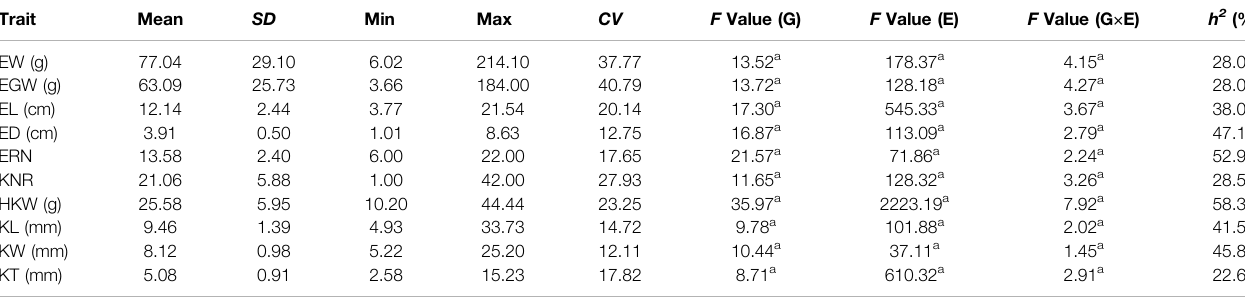
TABLE 1 | Descriptive statistics and ANOVA results of the maize ear-related traits.